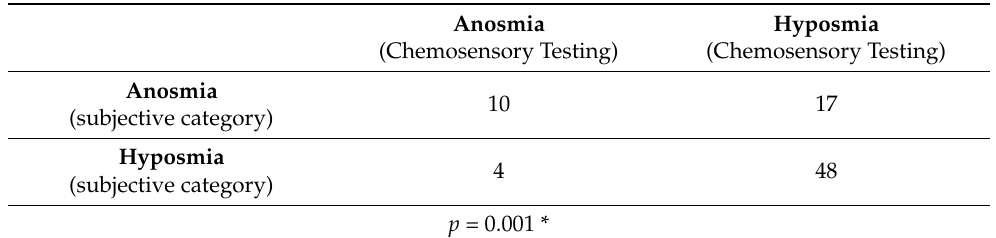
Table 2. Comparison between subjective and chemosensory testing categories. Statistical analysis was performed using the Chi-square test. A p -value below 0.05 was defined as a significant correlation indicated by the * sign. The parameters show the number of cases.